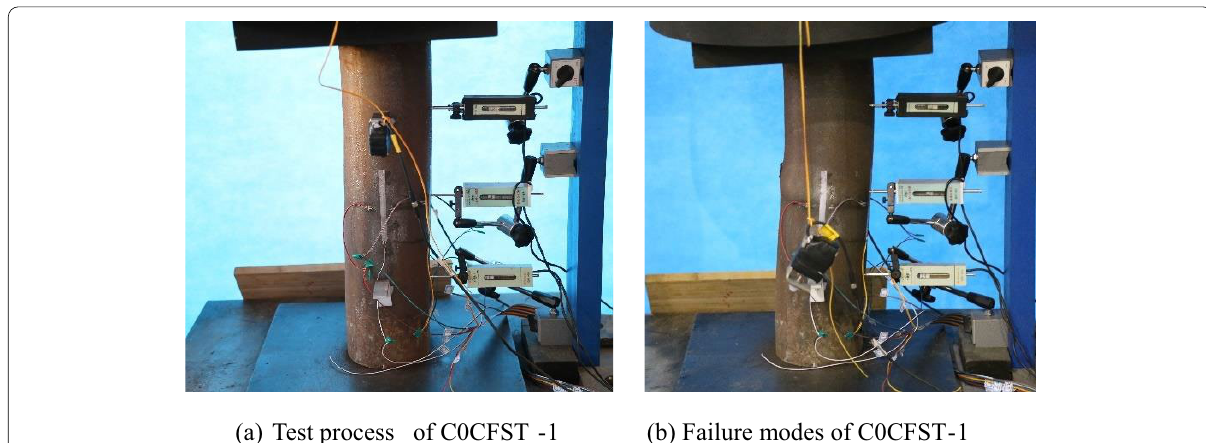
Fig. 8 Failure mode of unconfined concrete-filled steel tube